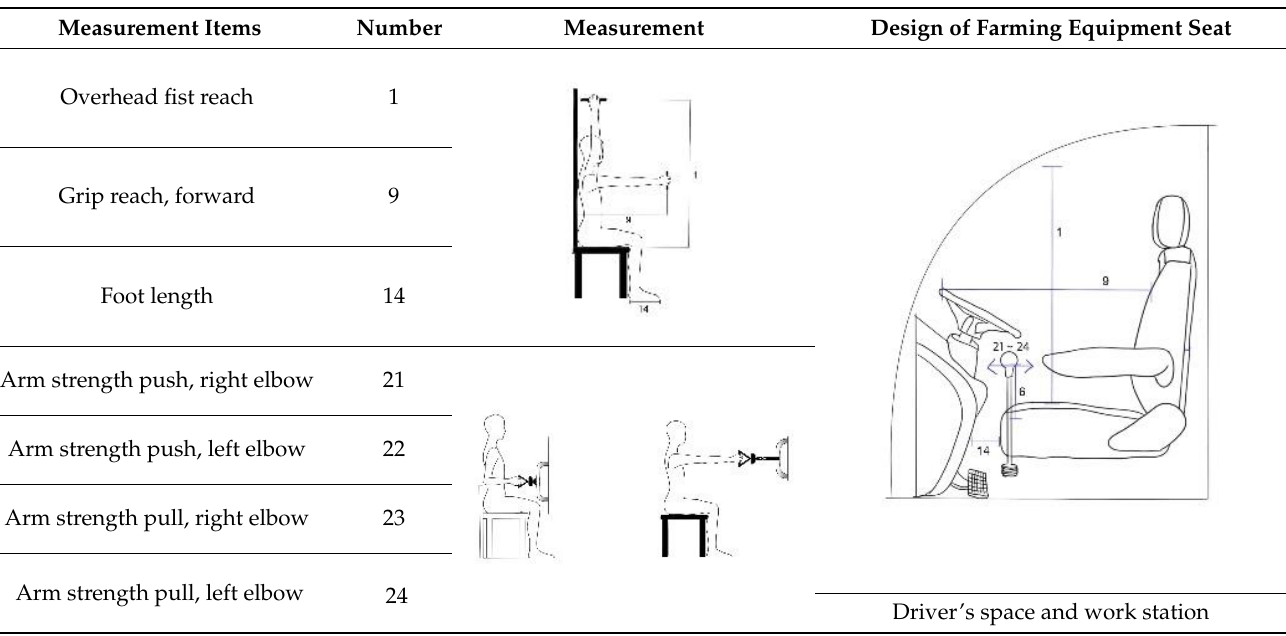
Table 2. Relationship between the measurement items, measurement, and design of the farming vehicle seat.